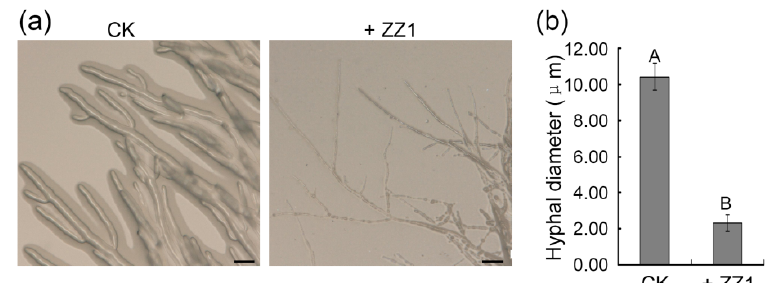
Figure 2. Effect of ZZ1 isolate on hyphal morphology of V. pyri . ( a ) Hyphae morphology of V. pyri after antagonism with ZZ1. The picture was taken at 2 days after antagonism with ZZ1 with an ultra-depth three-dimensional microscope. Bar = 10 μ m. ( b ) Hyphal diameter of V. pyri after antagonism with ZZ1. Values are means ± SD from ten replicates. Letters above the bars indicate statistical significance ( p < 0.01) based on Tukey’s test.